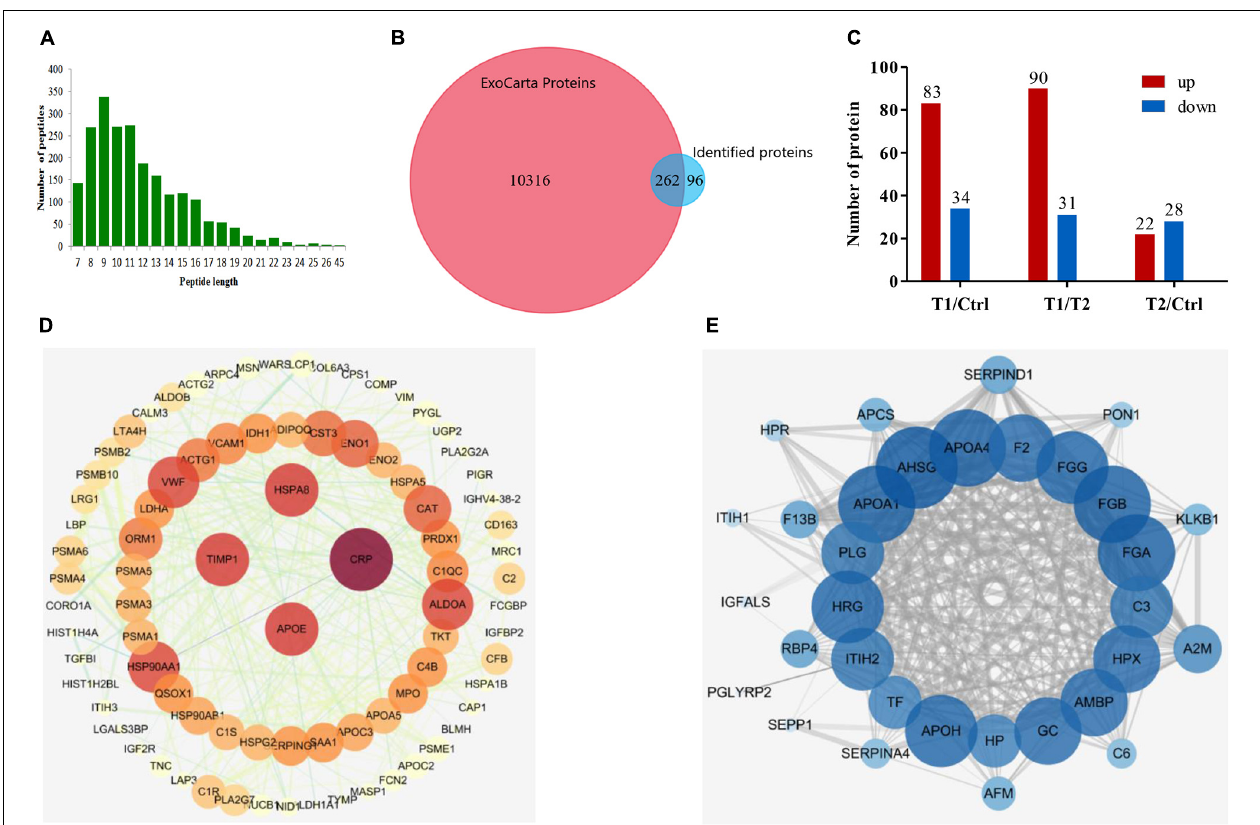
FIGURE 2 | Characteristics of the plasma exosomal proteins and protein–protein interaction mapping. (A) Length distribution of peptides detected by LC-MS/MS after trypsin digestion. (B) Venn diagram presentation of overlaps and differences between identified exosomal proteins and the ExoCarta database. (C) Statistical information of differentially expressed proteins among the three groups of samples. (D) PPI network mapping of upregulated differentially expressed proteins in patients with EBV-HLH. (E) PPI network mapping of downregulated differentially expressed proteins in patients with